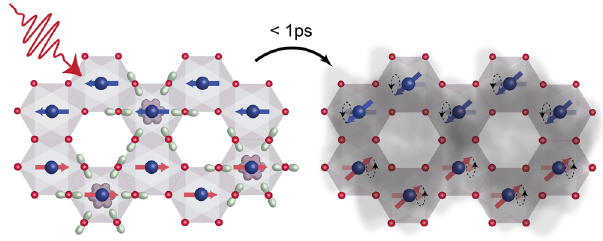
Fig. 4 Cartoon of the photoinduced dynamics. A near-infrared pump pulse excites the spin--orbit-entangled excitons in NiPS 3 (left panel). The purple shape around the Ni atoms (blue spheres) represents the region where the electron density is con fi ned, whereas the light green structures around the S atoms (red spheres) de fi ne where the hole density is distributed. These wavefunctions are computed considering the difference in electron density between the ground state with 3 T 2 g symmetry and the excited state with fi guration interaction theory. Through their 1 A 1 g symmetry using con coupling to the underlying antiferromagnetic order, the excitons launch a coherent spin precession (denoted by the circular motion of the red and blue arrows, right panel). Within 1 ps, the excitons also dissociate into itinerant carriers yielding a conducting state (gray shading) on top of the persisting long-range antiferromagnetic